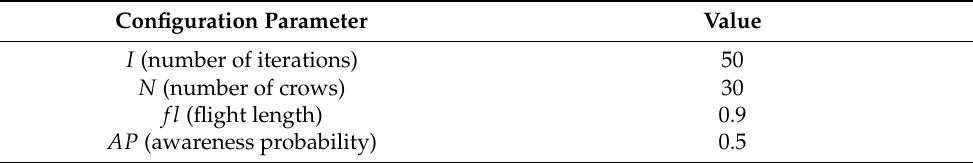
Table 8. BCSA Configuration Parameters.